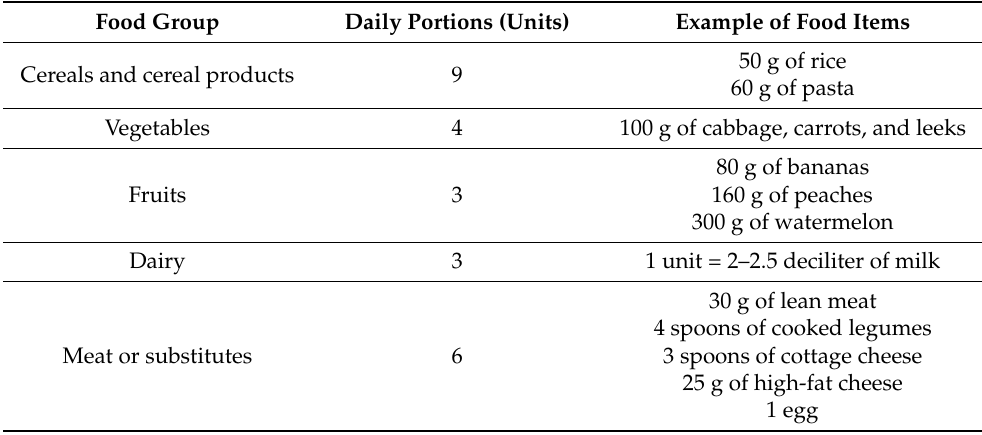
Table 2. Effect of exercise and nutrition intervention on body composition and muscle mass components. Variable